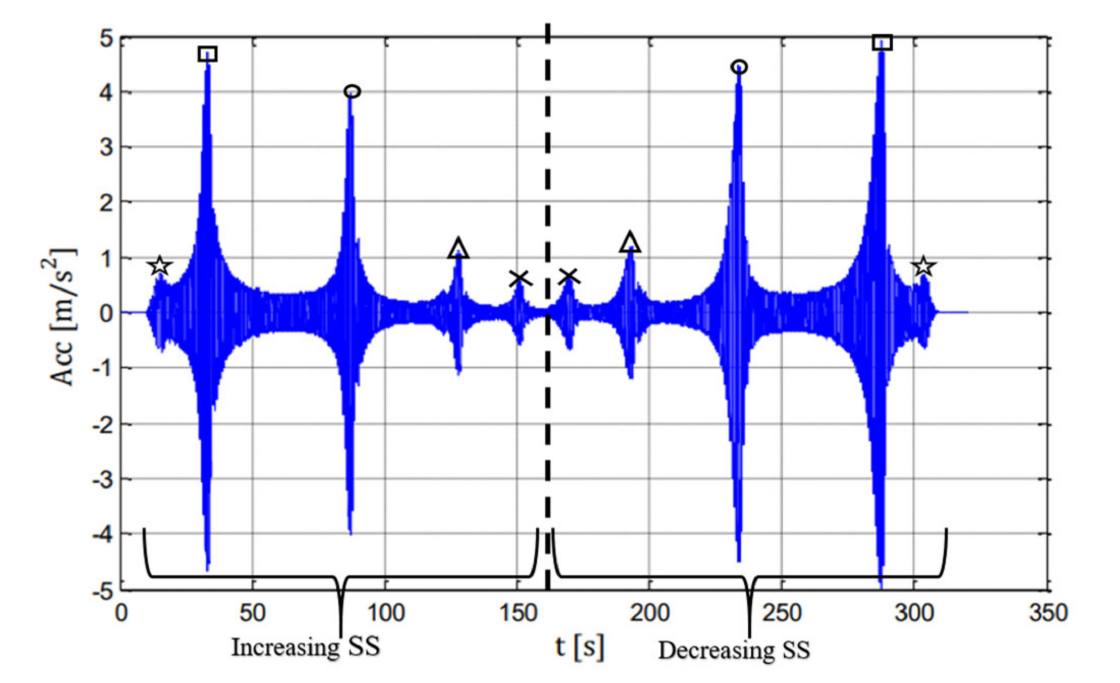
Figure 11. SS. FTMD configuration absolute acceleration at first floor for increasing and decreasing sine sweep. Stars, squares, circles, triangles, × represent same resonances at increasing and decreasing sweep